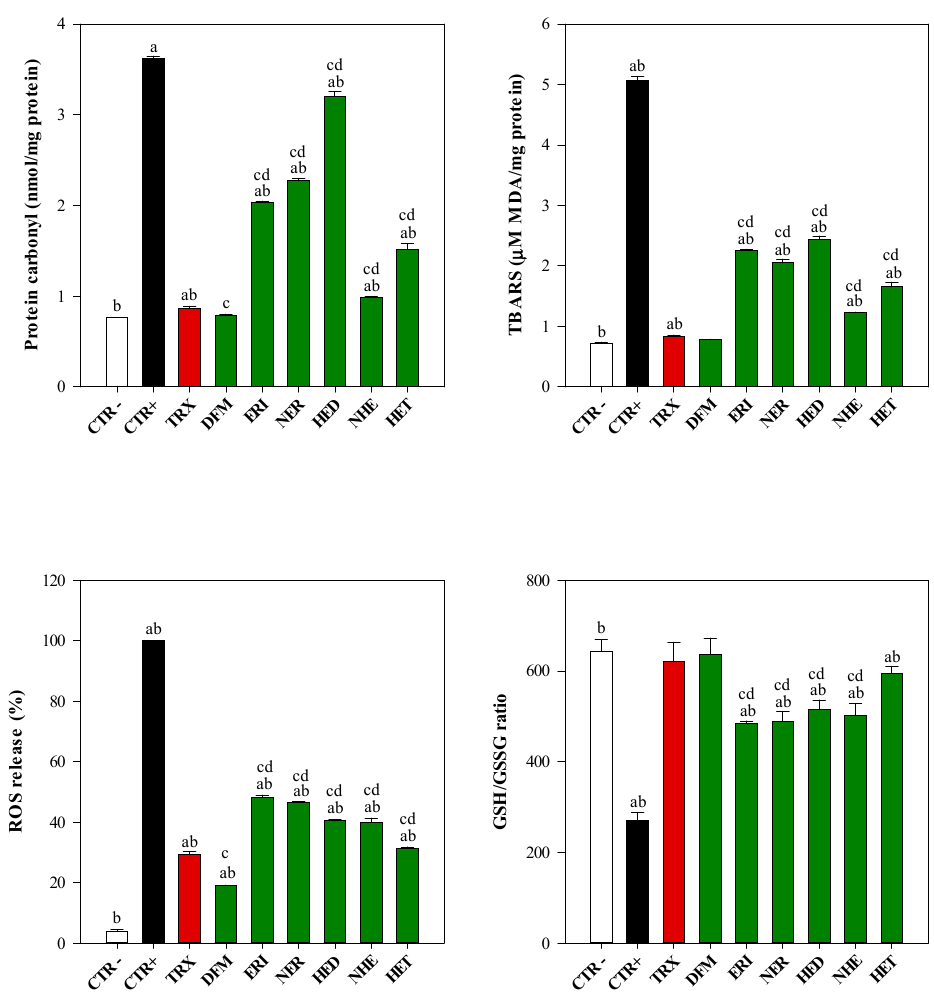
Figure 5. Exposure to 25 ng/mL IL-1 β causes pro-oxidant response in Caco-2 monolayers. CTR − , negative control treated only with culture medium; CTR+, positive control treated with 25 ng/mL IL-1 β ; TRX, 10 µ M Trolox, used as reference standard; DFM, 10 µ M digested flavanone mix; NHE, 10 µ M neohesperidin; ERI, 10 µ M eriocitrin; HET, 10 µ M hesperetin; NER, 10 µ M neoeriocitrin; HED, 10 µ M hesperidin. a p < 0.001 vs. CTR − ; b p < 0.001 vs. CTR+; c p < 0.05 vs. TRX; d p < 0.05 vs. DFM.